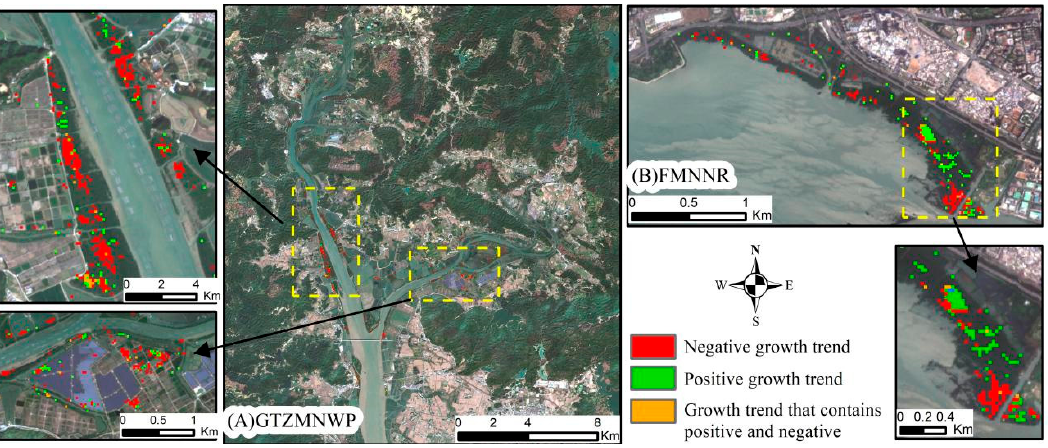
Figure A8. The growth trends of stable mangroves occurred in ( A ) GTZMNWP and ( B ) FMNNR in 2000–2020. Table A1. The quantity relationship of lost mangrove pixels and the distances between mangroves and driving factors in GTZMNWP.